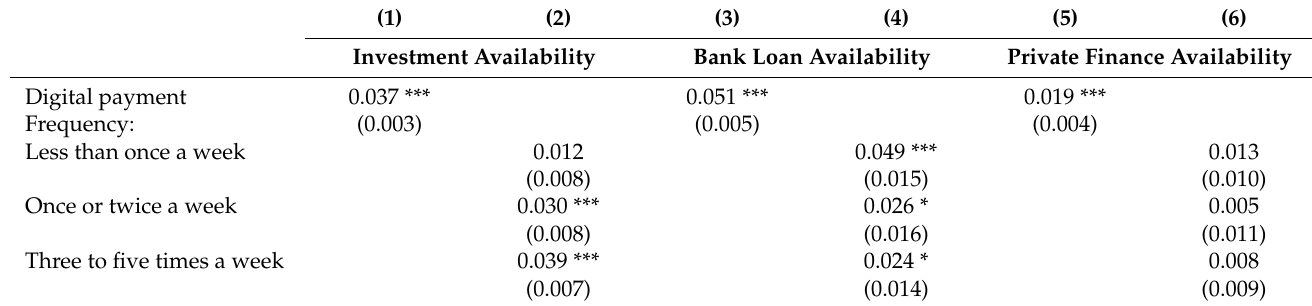
Table 9. Digital payment adoption and the investment, bank loan, and private finance availability indices (estimated by OLS